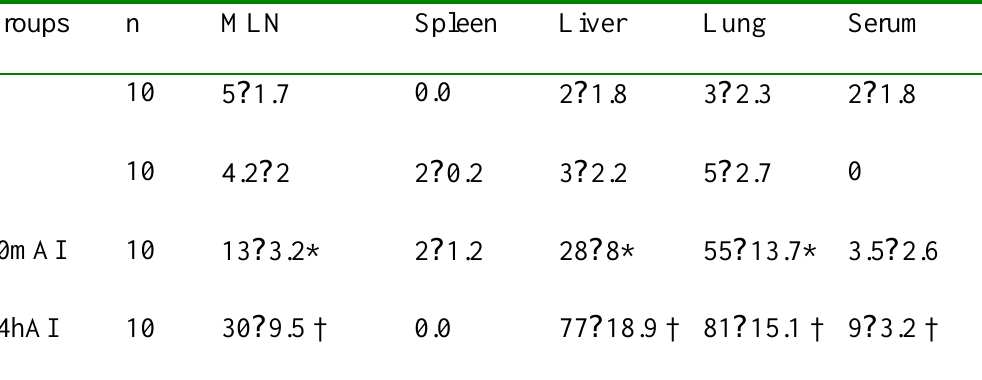
TABLE 2 - Magnitude (CFU per gram of tissue) of bacterial translocation to several organs and